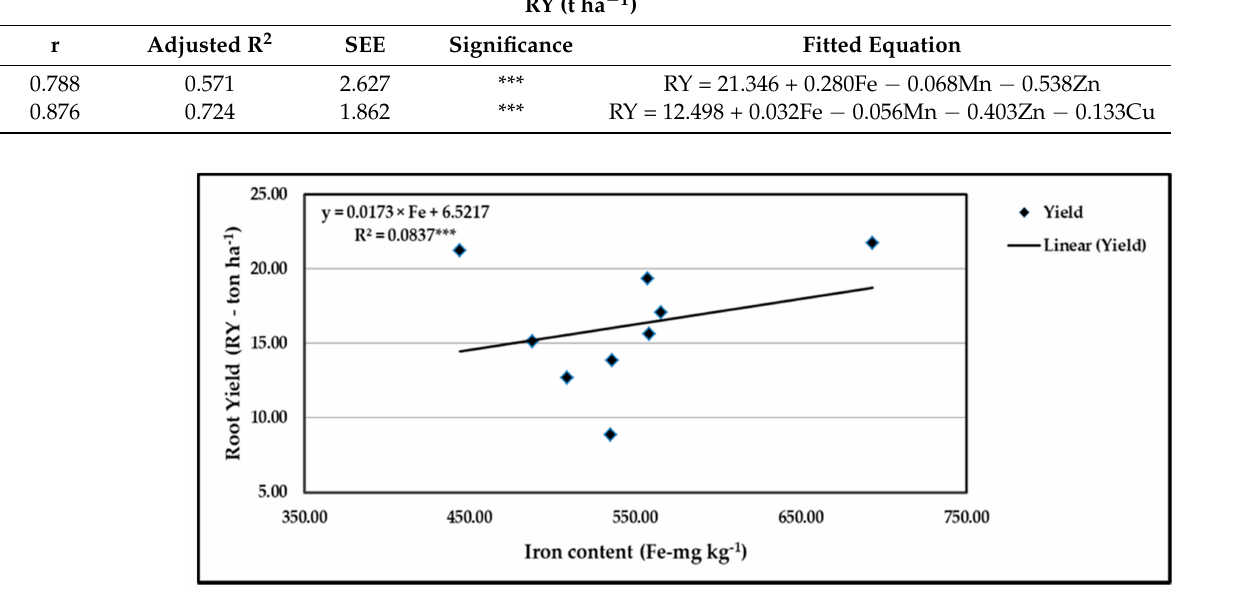
Figure 15. Contribution of Fe content to the quadratic response of stressed sweet potato to different levels of ascorbic acid and zinc oxide nanoparticles in the 2019 season. *** indicates differences at p ≤ 0.001 probability